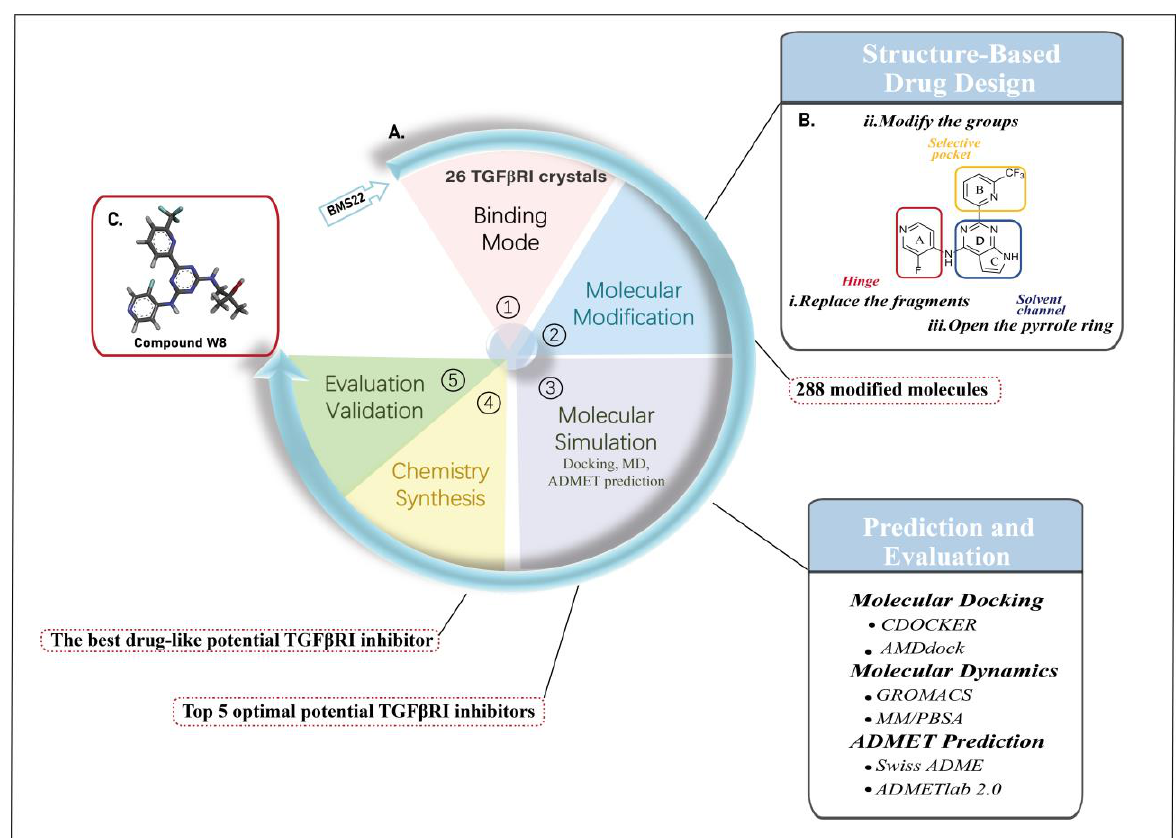
Figure 3 . The flow chart to identify the optimal drug- like TGFβR Ⅰ inhibitors ( A : the whole Figure 3. The flow chart to identify the optimal drug-like TGF β RIinhibitors (( A ) the whole workflow; workflow; B : a schematic of molecular modification; C : the final screened molecule). ( B ) a schematic of molecular modification; ( C ) the final screened